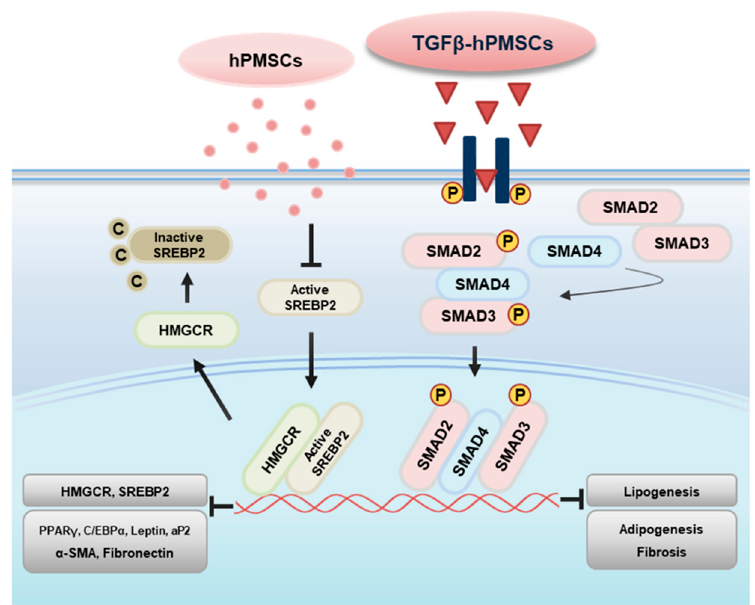
Figure 5. Proposed pathway of TGF β -hPMSCs regarding anti-adipogenesis in TAO. TGF β -hPMSCs stimulate TGF β signal transduction by binding to transmembrane receptors. The phosphorylated receptors transmit signaling by phosphorylating Smad 2/3 and inducing their binding to Smad 4. The Smad complex translocates into the nucleus and acts as transcription factors to inhibit lipogenic gene (e.g., HMGCR and SREBP2) and adipogenic gene (e.g., PPAR γ , C/EBP α , Leptin, and aP2) transcription, as well as fibrotic gene transcription, including a-SMA and Fibronectin.